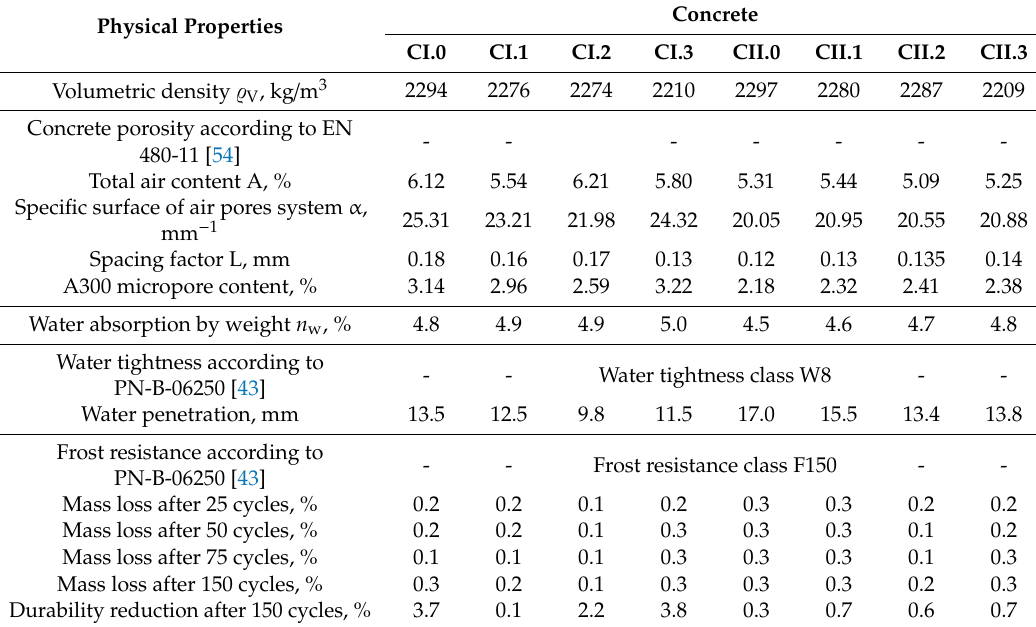
Table 9. Mean values of open porosity, volumetric density and water absorption of